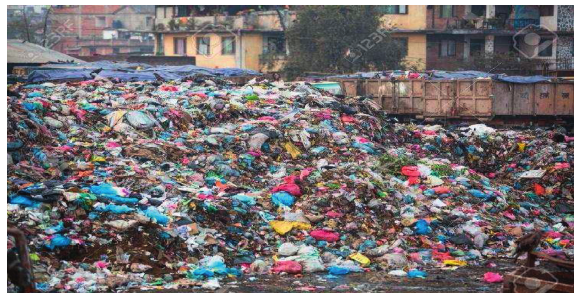
Figure 1: Plastic waste around Kathmandu Valley, the study site of this research [19].